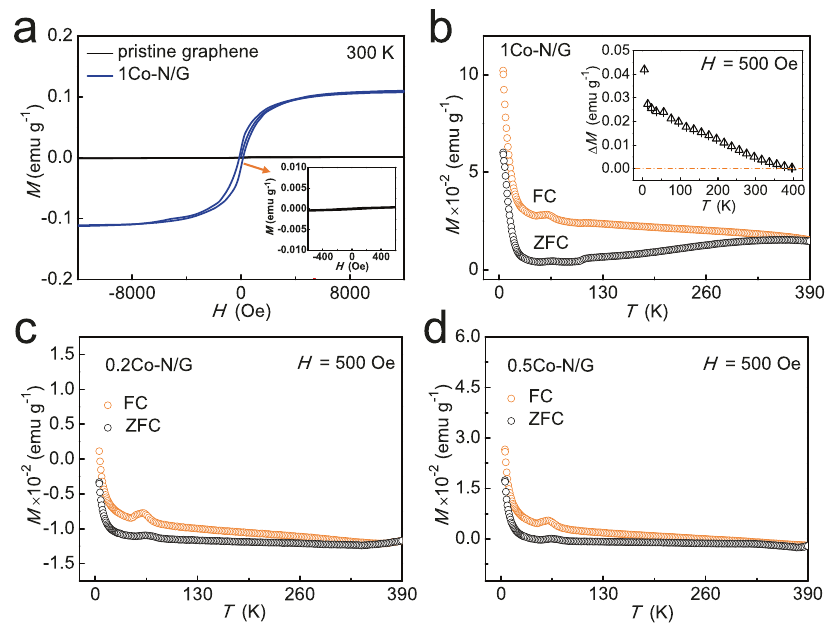
Fig. 4 Magnetic properties. a Magnetization vs. magnetic fi eld ( M – H ) curves for pristine graphene and 1Co-N/G nanosheets after background subtraction. The inset shows the M – H curves for pristine graphene in narrow scale for better perception. b Temperature dependence of FC and ZFC magnetization ( M – T ) curves for 1Co-N/G nanosheets. Inset: the magnetization difference ( Δ M ) between FC and ZFC curves ( M FC – M ZFC ) of 1Co-N/G nanosheets. c , d Temperature dependence of FC and ZFC magnetization ( M – T ) curves for 0.2Co-N/G ( c ) and 0.5Co-N/G ( d )